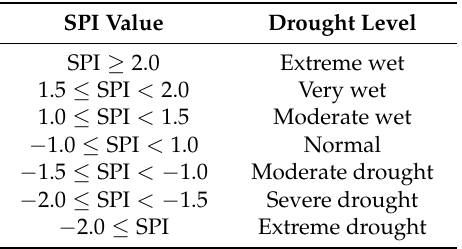
Table 2. Drought intensities according to SPI